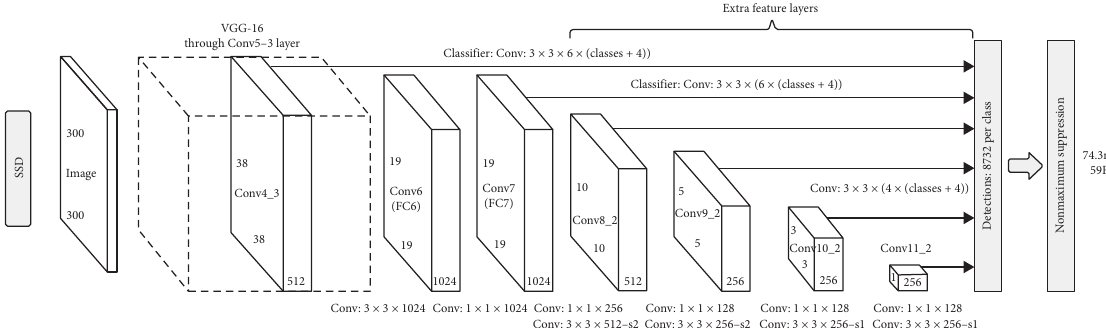
Figure 6: SSD network structure [25].